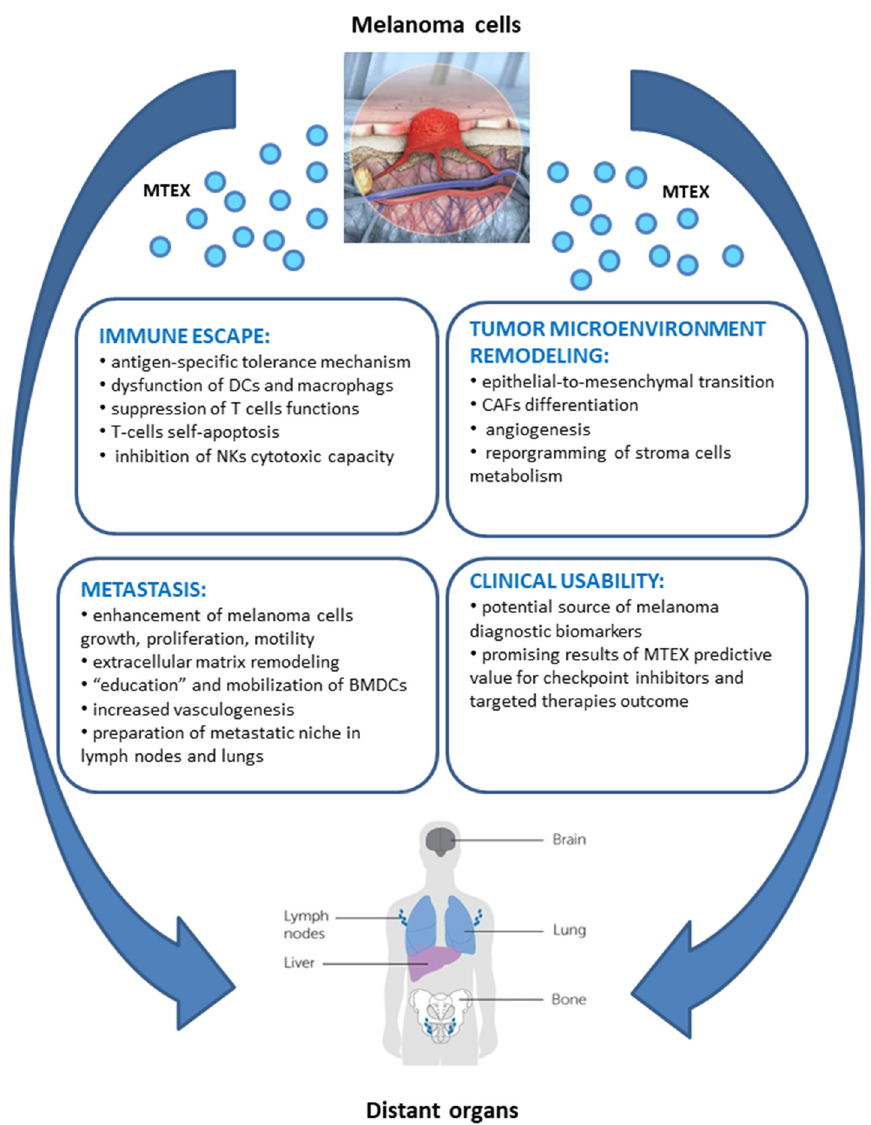
Figure 2. Pleiotropic effect of MTEX on melanoma biology.